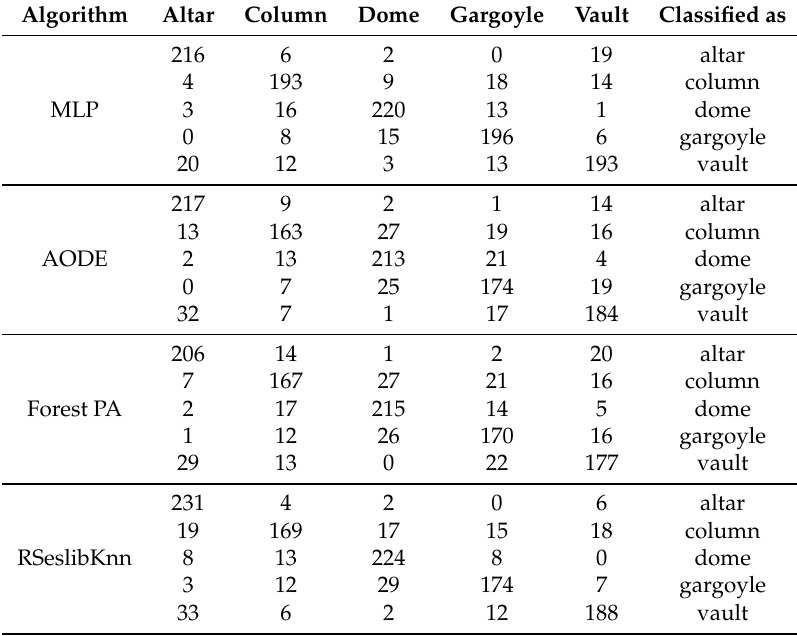
Table 3. The confusion matrices for each algorithm, before attribute